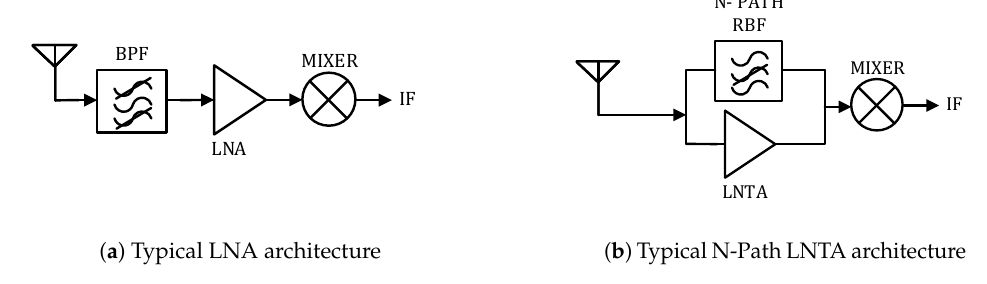
Figure 1. LNA and LNTA front-end receiver architectures for wideband